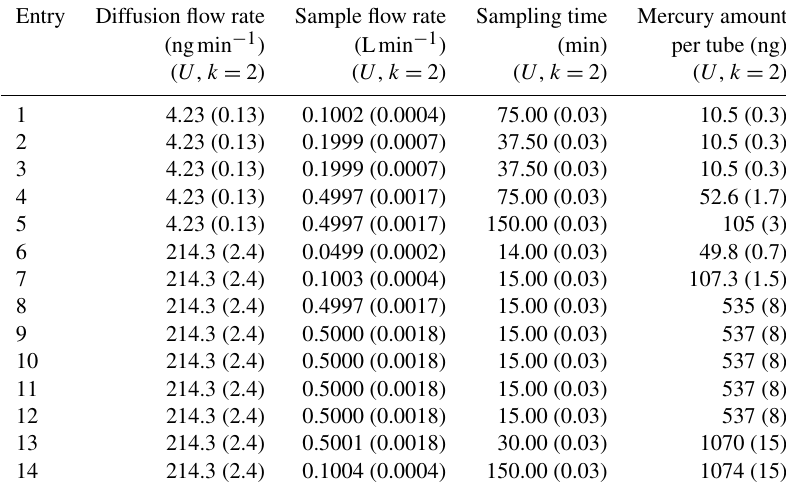
Table 3. Parameters used to sample sorbent tubes from the primary mercury gas standard for the second comparison.